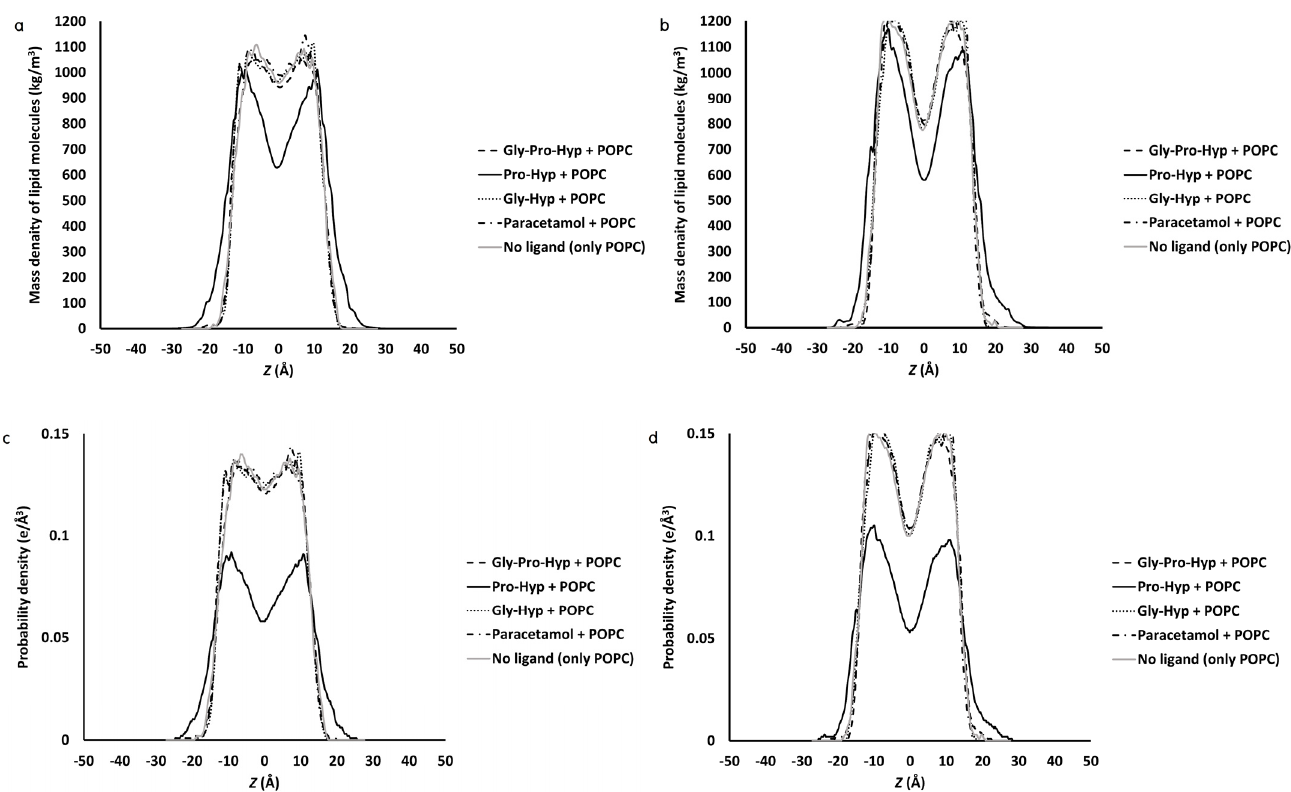
Figure 8. Mass density profiles of ( a ) palmitoyl groups and ( b ) oleoyl groups, and electron density profiles of ( c ) palmitoyl groups and ( d ) oleoyl groups, across the ligand ‒ POPC bilayer models. z = 0 corresponds to the center of the bilayer.